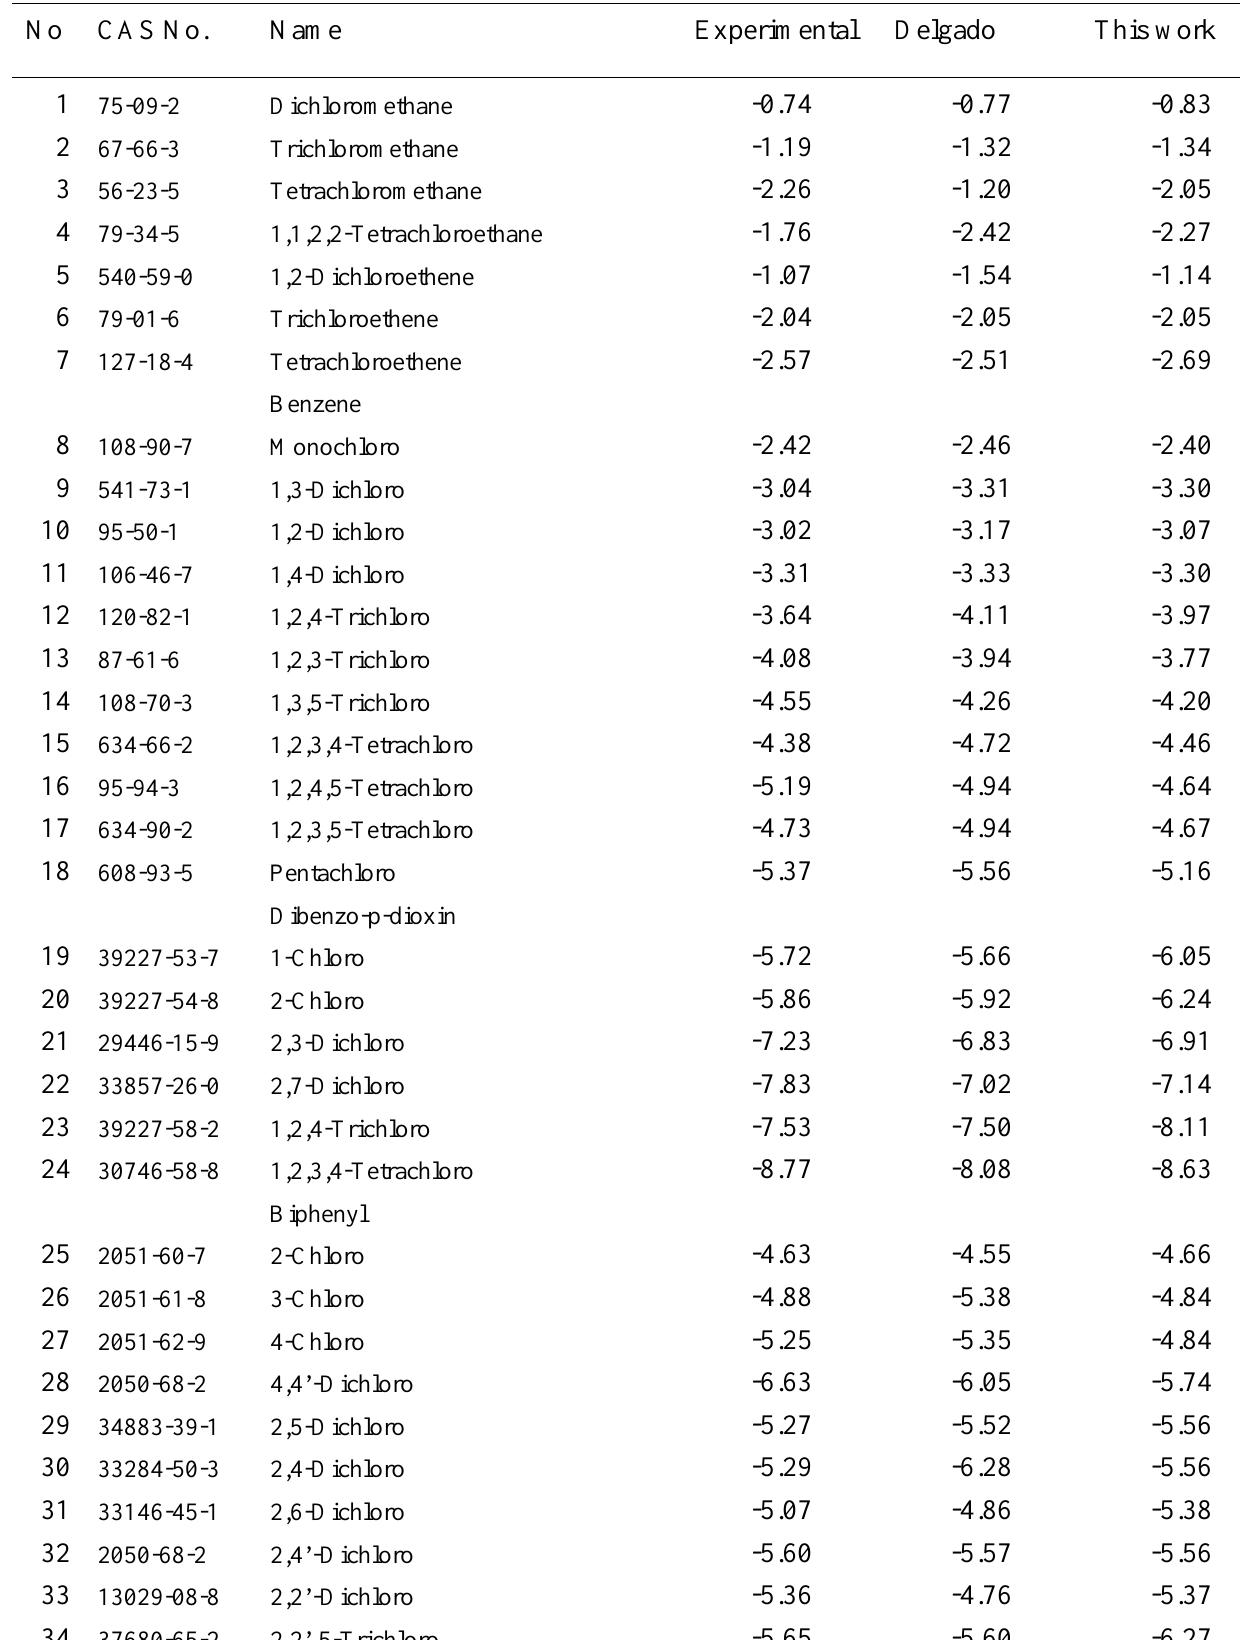
Table 3. Calculated results of the molar aqueous solubility of the 50 compounds